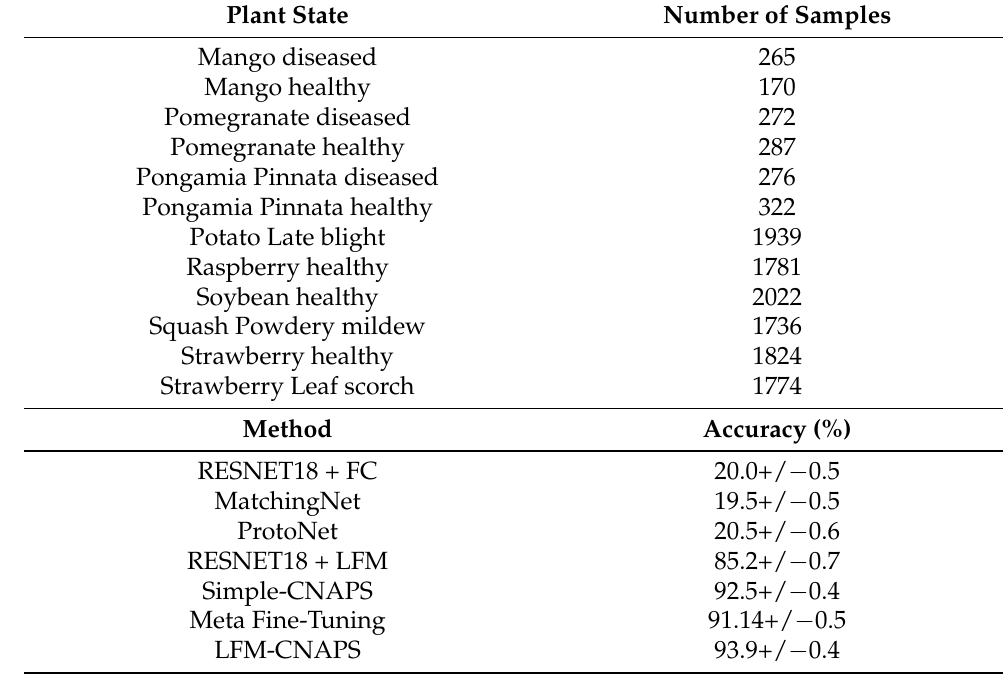
Table 4. LFM-CNAPS test results on an Out-of-Domain Miniplantdisease-Dataset.